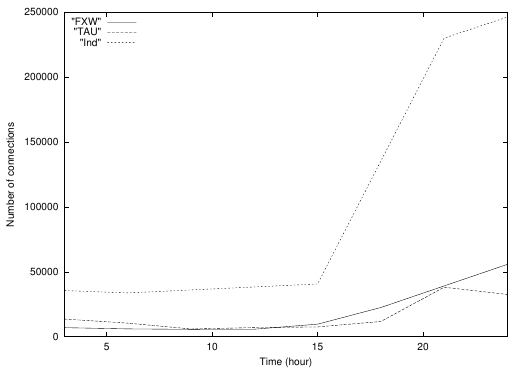
Fig. 3: Connections Peak during the Spreading of the Code Red